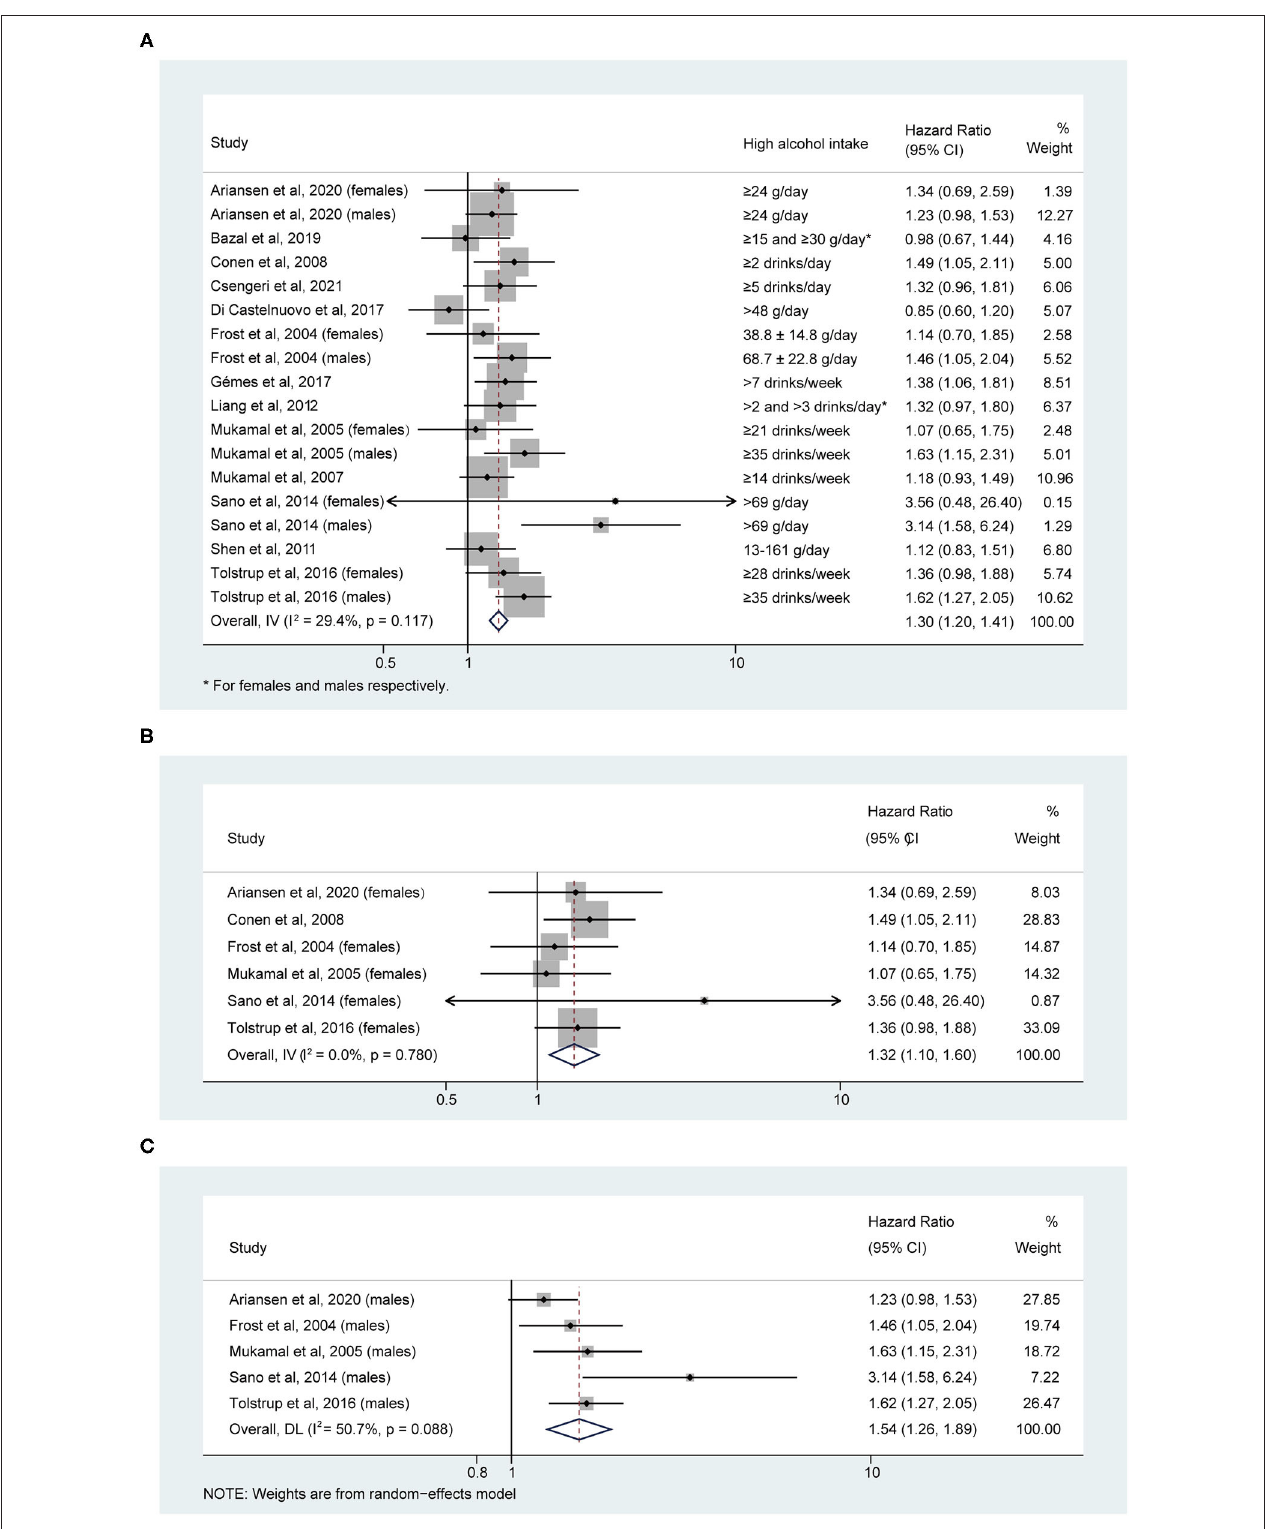
FIGURE 2 | Hazard ratios of risk of atrial fibrillation for high alcohol intake in (A) overall, (B) female, and (C) male individuals.